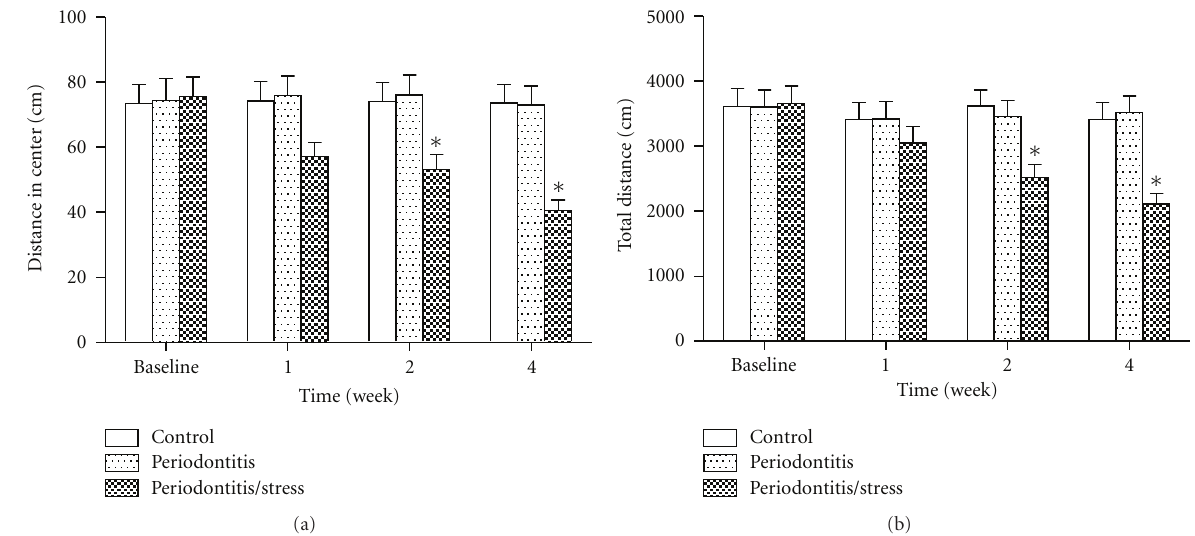
Figure 3: E ff ect of psychological stress on behavioral changes of rats in the open-field test. The distance moved in the center (a) and total 0 . 05 versus matched control group for the same time point. distance moved (b) were measured. (cid:0) P (cid:0)